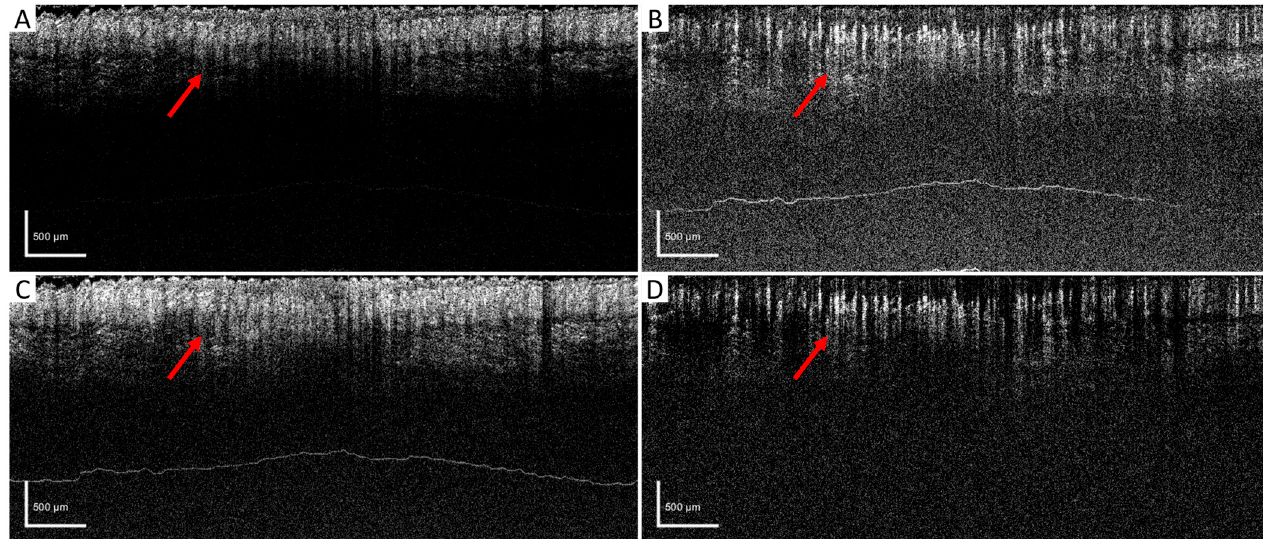
Figure 3. The average normal-distribution correlation coefficients with different window sizes.